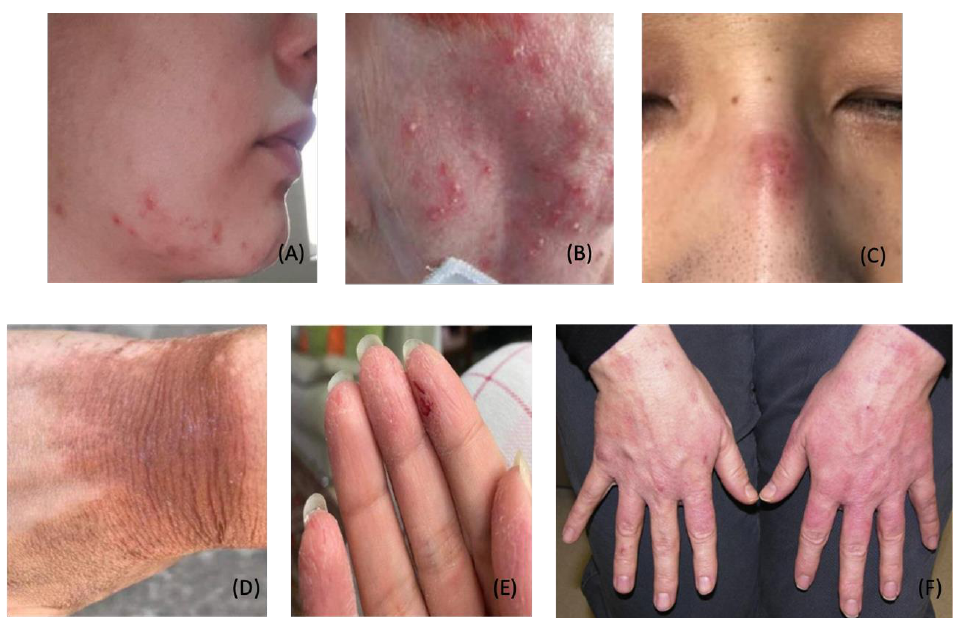
Figure 3. Dermatological Conditions Related to PPE and Hygiene Products. ( A ). Acne vulgaris; ( B ). Rosacea; ( C ). Pressure injury; ( D , E ). Irritant contact dermatitis; ( F ). Hand eczema; Photo credit is